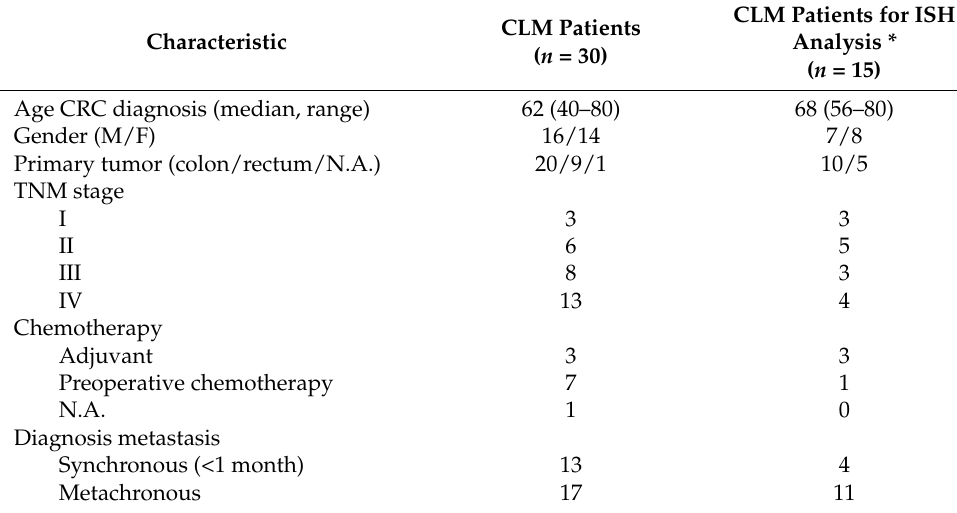
Table 1. Patient characteristics in the tissue cohort.